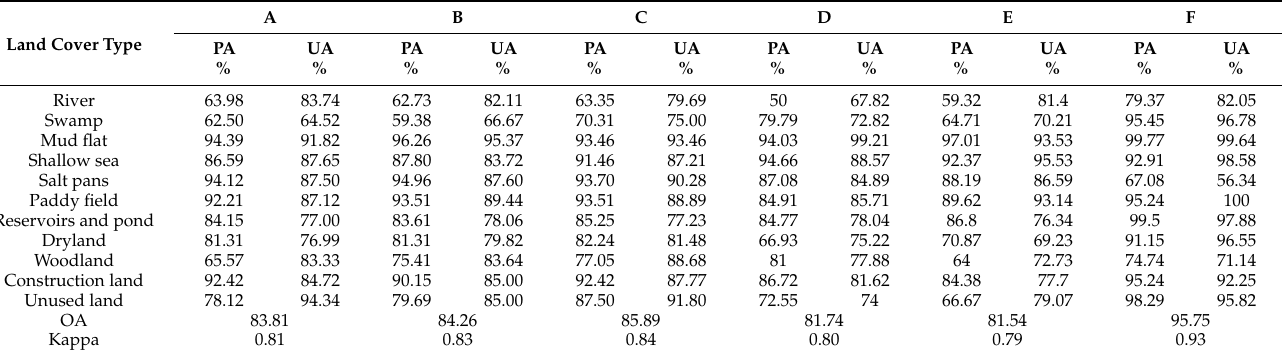
Table 6. Statistics for classification